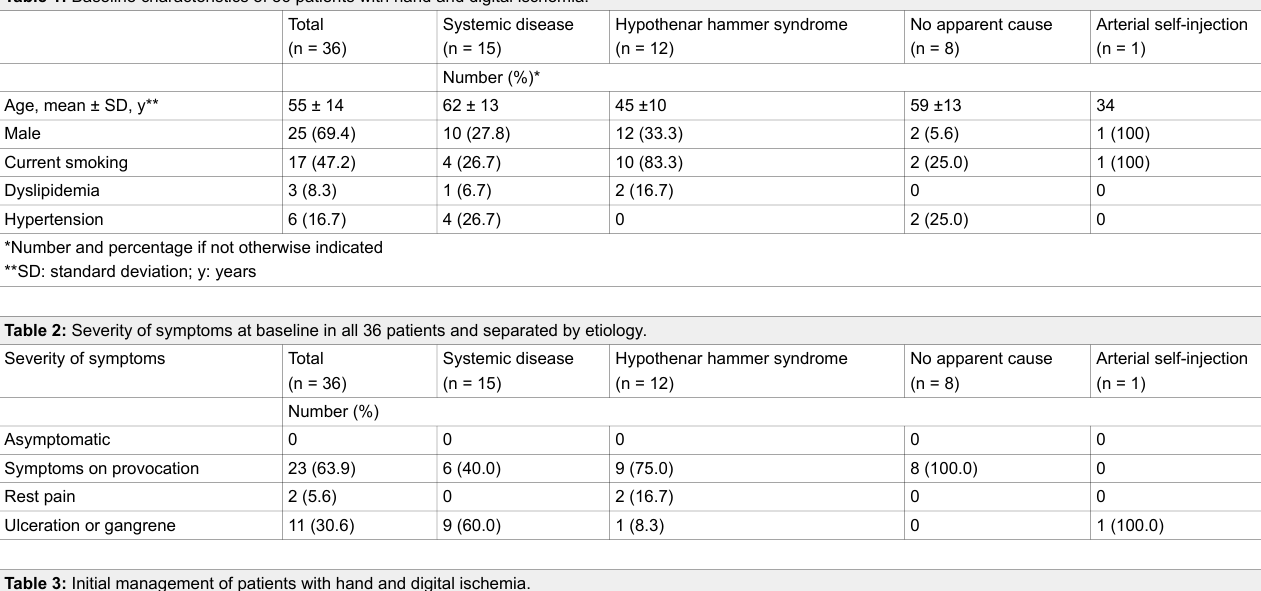
Table 3: Initial management of patients with hand and digital ischemia.